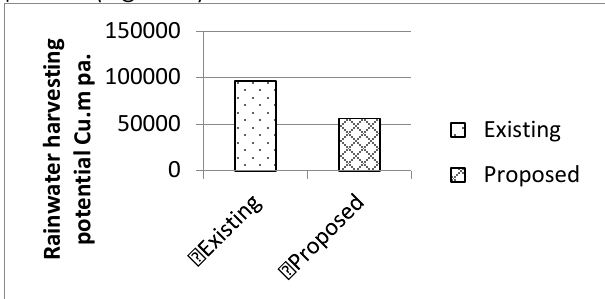
Figure 7. Comparison of rainwater harvesting potential